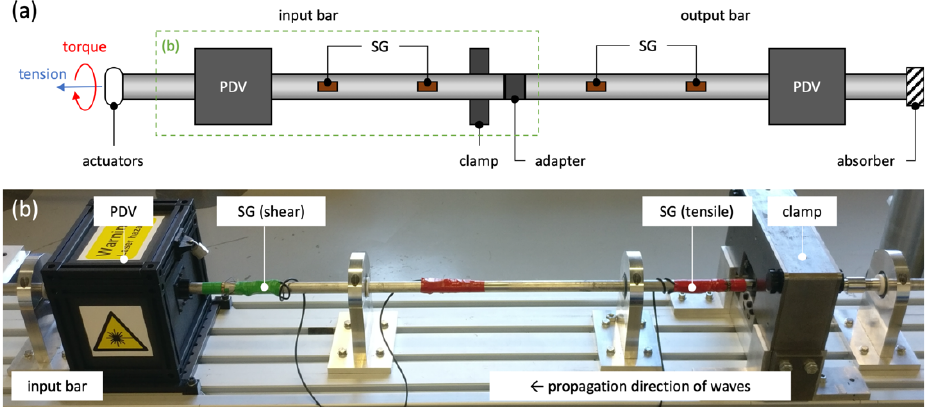
Fig. 1 .: (a) Schematic of the TTHB system; (b) input bar of the TTHB system with the indicated locations of the strain gauges (SG) and the PDV